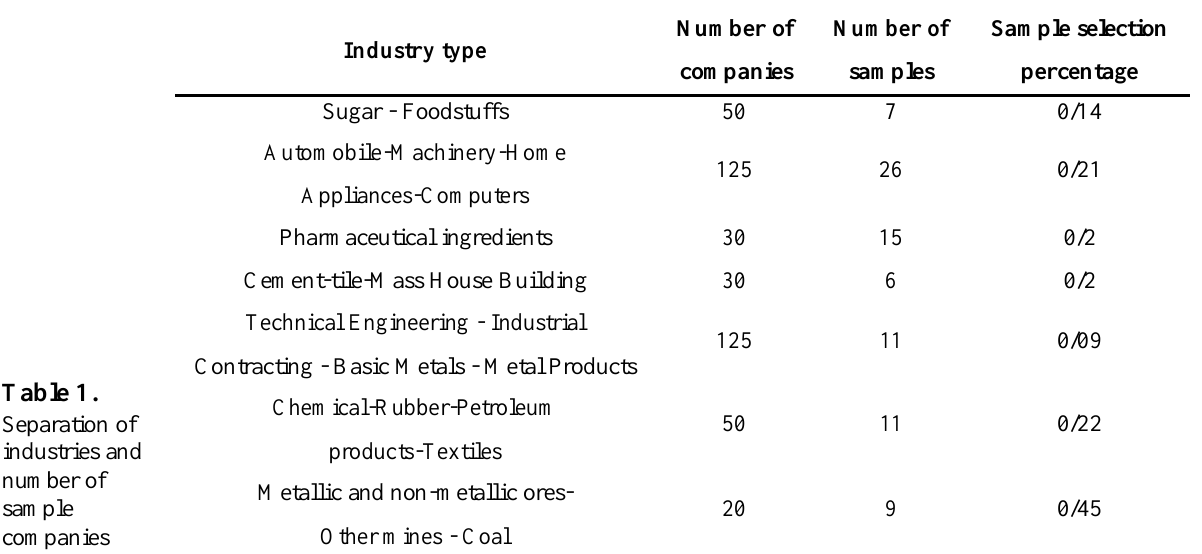
Chemical-Rubber-Petroleum Metallic and non-metallic ores-